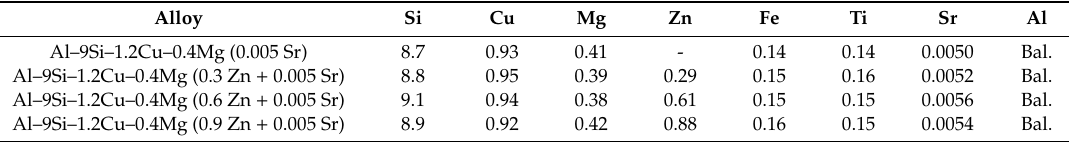
Table 3. Change of Zn element in alloy composition in